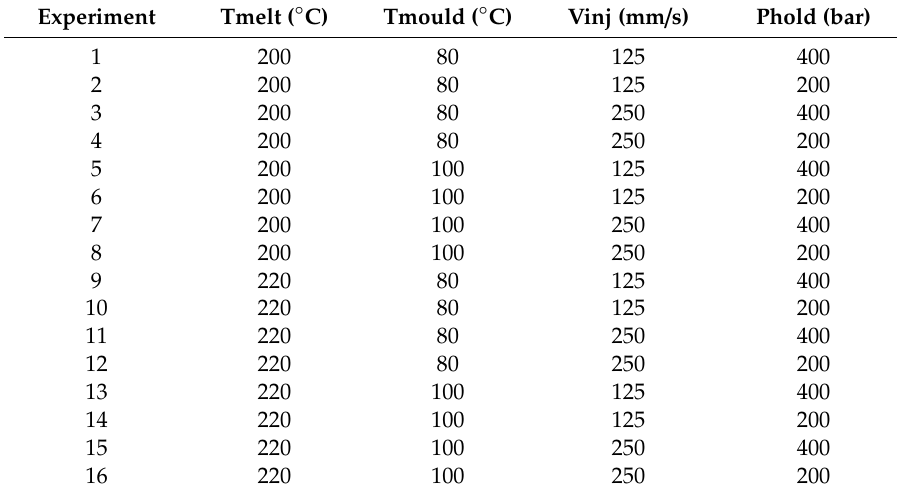
Table 4. Process parameter settings for the DoE